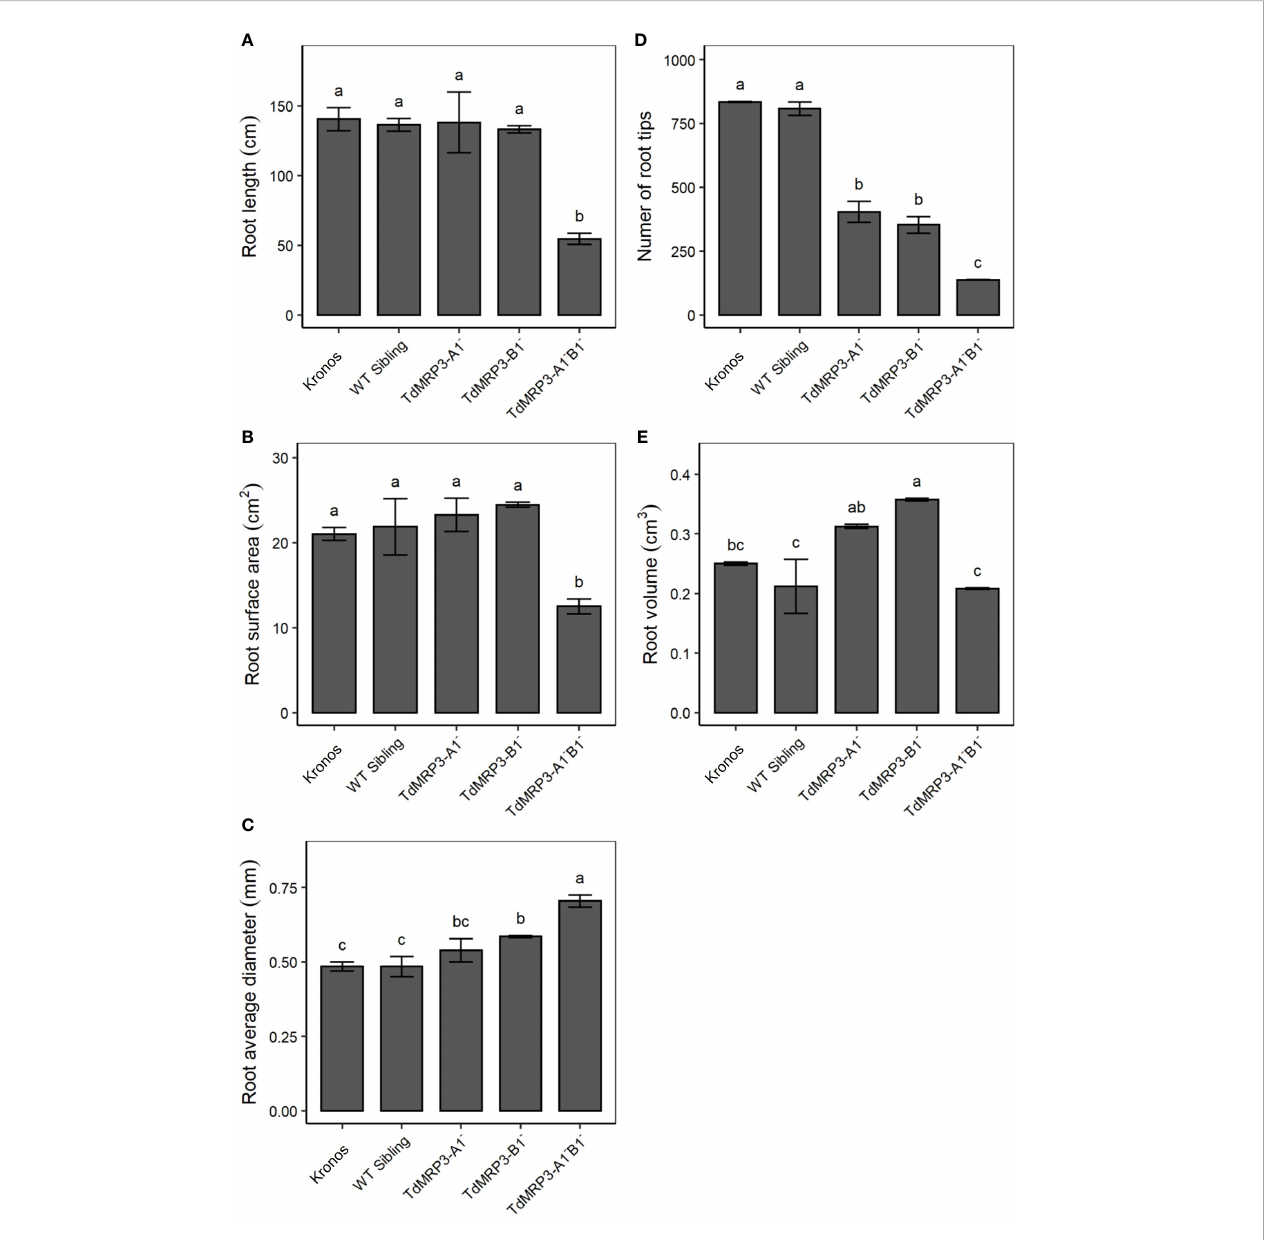
FIGURE 6 Root morphological traits: length (A) , surface area (B) , diameter (C) , number of root tips (D) and volume (E) in lpa mutants, WT sibling lines and cv. Kronos. Mean values of three biological replicates ± St. Dev. One-way ANOVA, LSD post hoc test, p